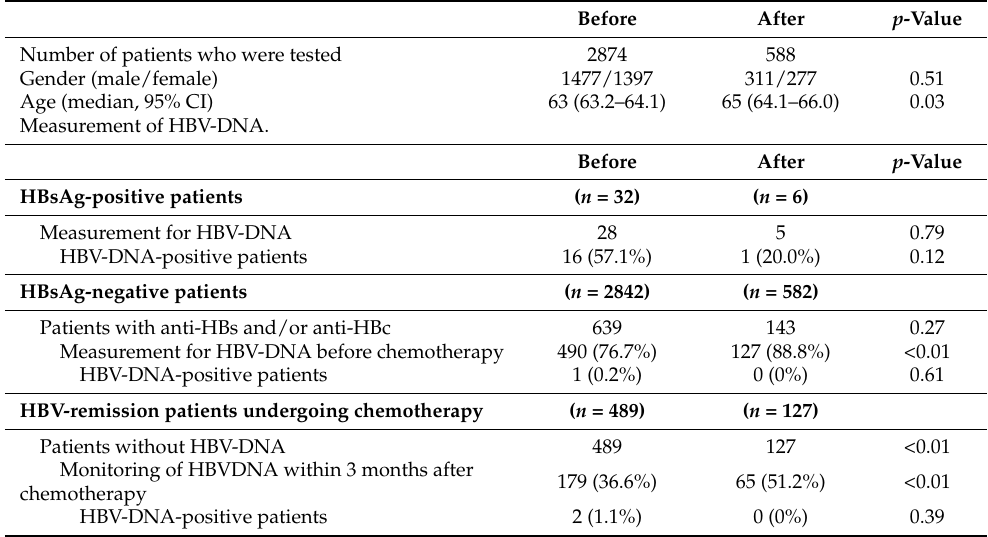
Table 4. Measurement rates of HBV-DNA in patients undergoing chemotherapy before and after the introduction of the alert